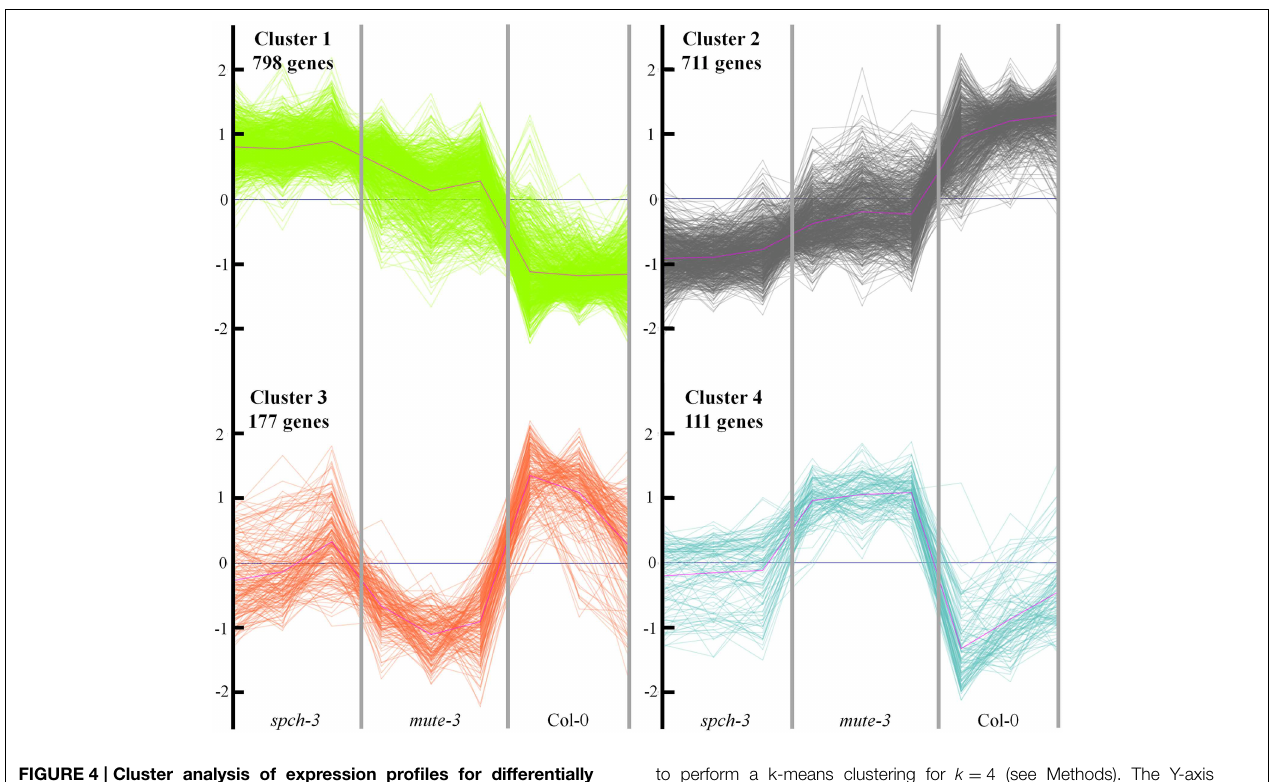
FIGURE 4 | Cluster analysis of expression profiles for differentially expressed genes in the three genotypes. A total of 1797 genes significantly ( FDR < 0.05) up- ( > 2 fold) or down ( < –2 fold) regulated in any of the mutants, with respect to Col-0 or between the two mutants, was selected. The normalized expression values were used